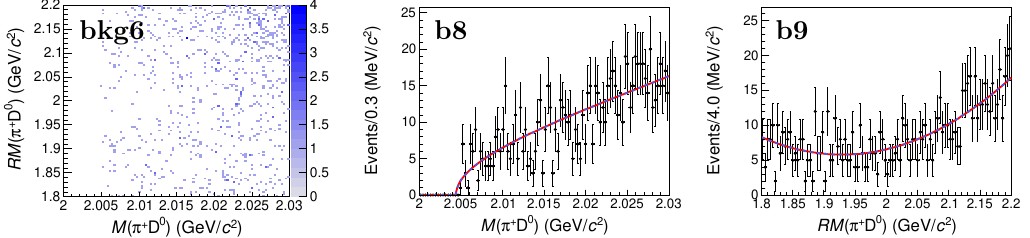
Figure 2. Distribution of the recoil mass RM ( π + D 0 ) versus the invariant mass M ( π + D 0 ) and the 2D fit result for the remaining background contributions of the generic MC samples after removing signal events and peaking background contributions mentioned in the text at 4.416 GeV c.m. energy. An Argus function and a second-order Chebyshev polynomial (red lines) are used to fit the M ( π + D 0 ) and RM ( π + D 0 ) distributions, respectively. Labels of bkg6, b8, and b9 are used in eq. (4.1) and described in